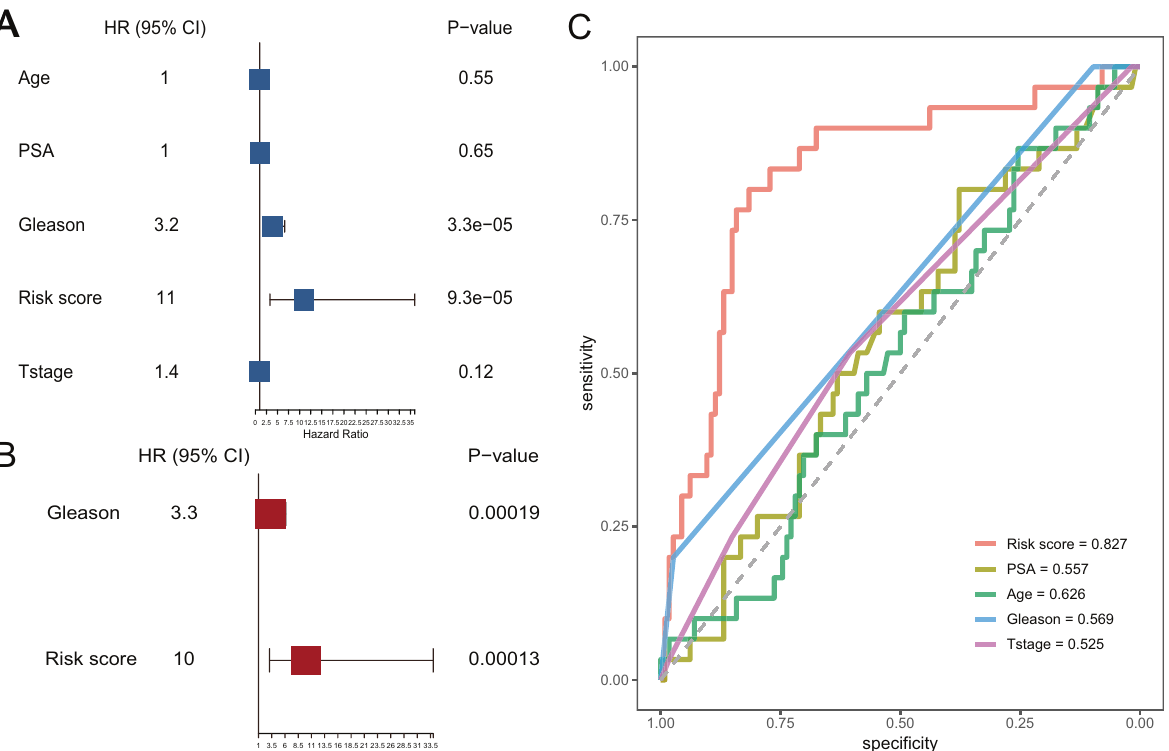
Fig. 4 Estimation of the prognostic accuracy of the autophagy-related circRNA signature and other clinicopathological factors in PCa patients. A Univariate Cox regression analysis shows the correlation between BCR-free survival and various clinicopathological parameters such as age, PSA, T-stage, GS, and the autophagy-related circRNA signature risk score. B Multivariate Cox regression analysis shows the correlation between BCR-free survival with GS and the autophagy-related circRNA signature risk score. C ROC analysis shows the prognostic accuracy of clinicopathological parameters such as age, PSA, T-stage, GS, and the autophagy-related circRNA signature risk